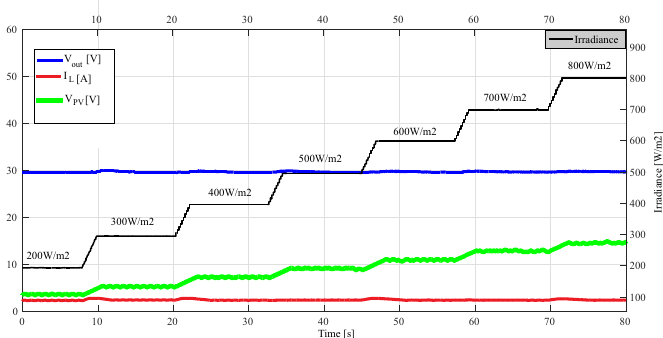
Figure 13. Irradiation levels and MPPT